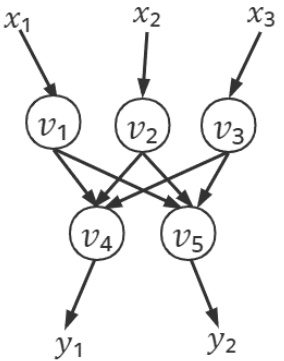
Figure 2. Decomposition of